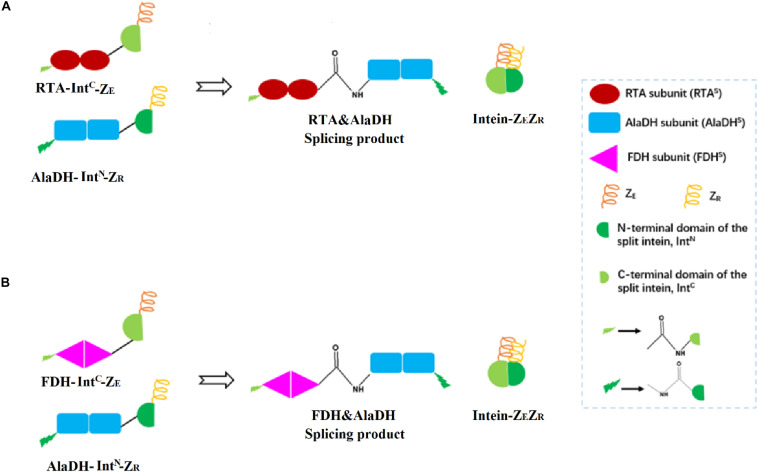
Schematic presentation for the ligations of multienzymes with peptide bonds through hetrosubunit splicing triggered by the dimerization of ZE and ZR. (A) The RTA subunit (RTAS) is ligated to the AlaDH subunit (AlaDHS) forming the splicing product RTA&AlaDH. (B) The FDH subunit (FDHS) is ligated to AlaDHS forming the splicing product FDH&AlaDH. ZR, arginine-rich leucine zipper; ZE, glutamic acid-rich leucine zipper.